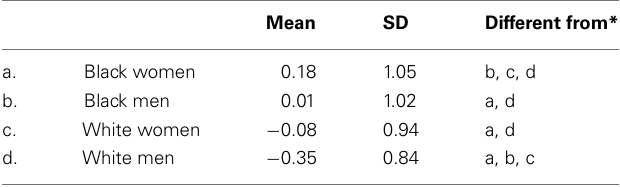
Table 6 | Mean distress by race–sex subgroup ( N =